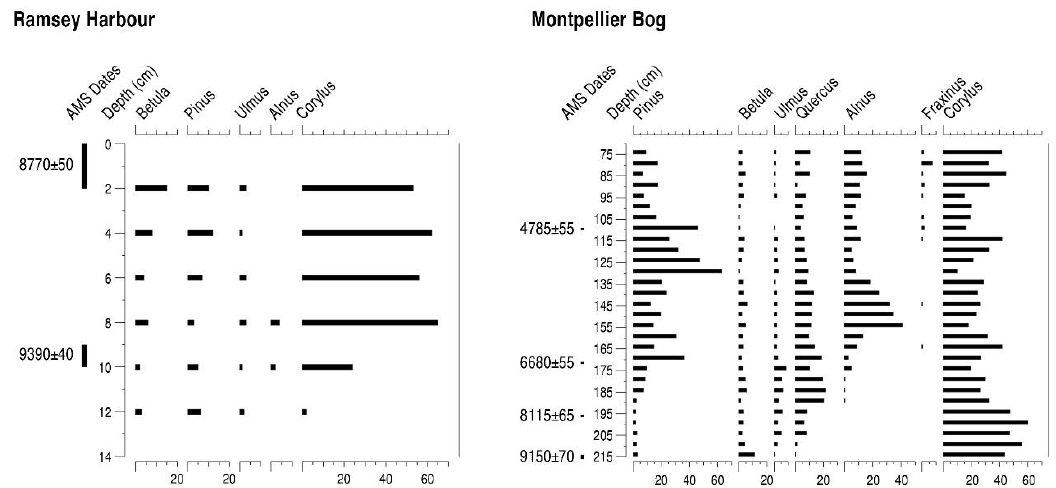
Figure 8. Percentage pollen diagrams from Ramsay Harbour and Montpellier Bog, Isle of Man, showing selected tree taxa and 14 C BP AMS ages.